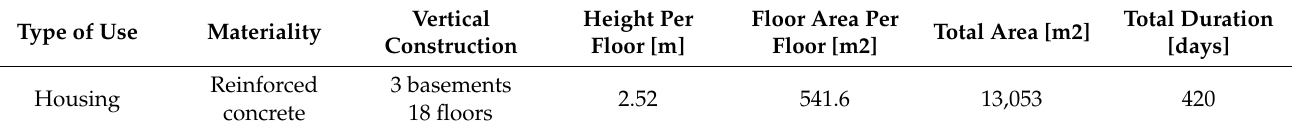
Table 3. Project characteristics for the case